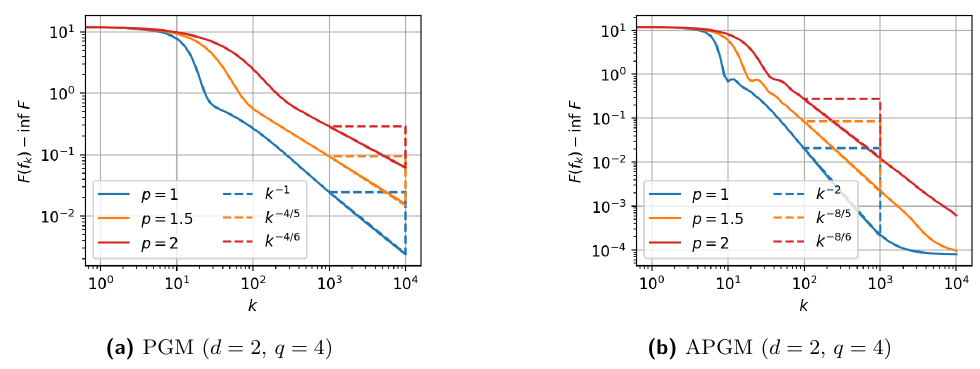
Figure 6 Convergence of PGM and APGM vs. theoretical rates (up to log factors) in a sparse deconvolution problem with H = ι M and d = 2. Here p refers to the parameter of η p and p = 1 + (Θ) refers to η ent . The objective has structure (II*) so q = 4 in the rates of Table 2.